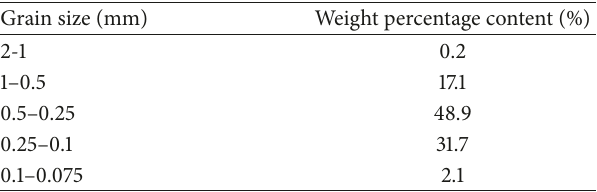
Table 1: Grain size distribution of